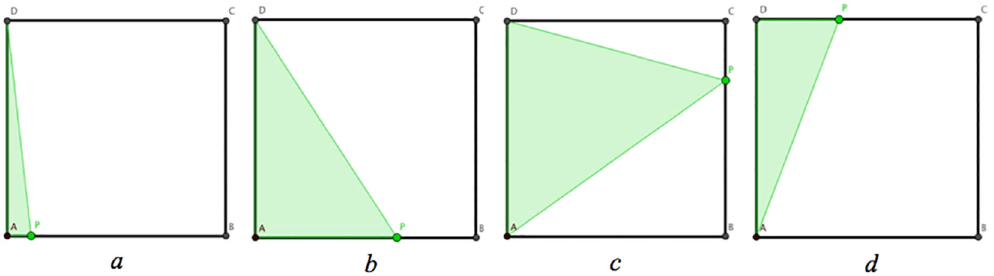
Figure 5. Four screen captures of a movie of a point sweeping out a